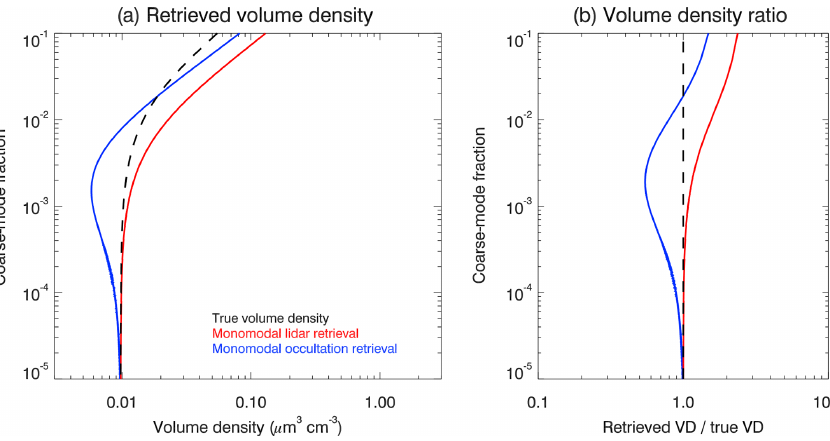
Figure 8. Similar to Fig. 3 but for volume density.